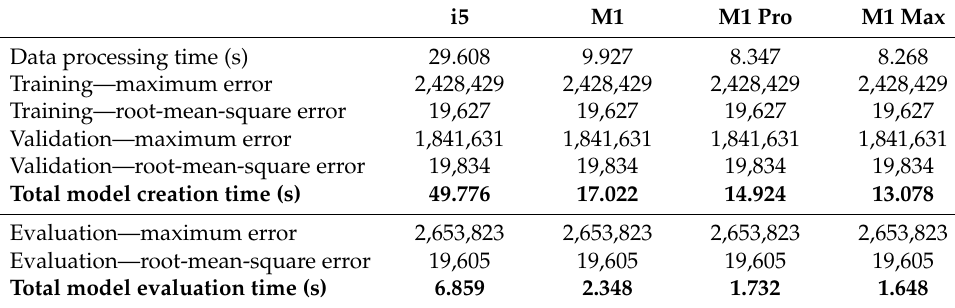
Table 10. Average test results for the ‘SteamReviewsCleaned’